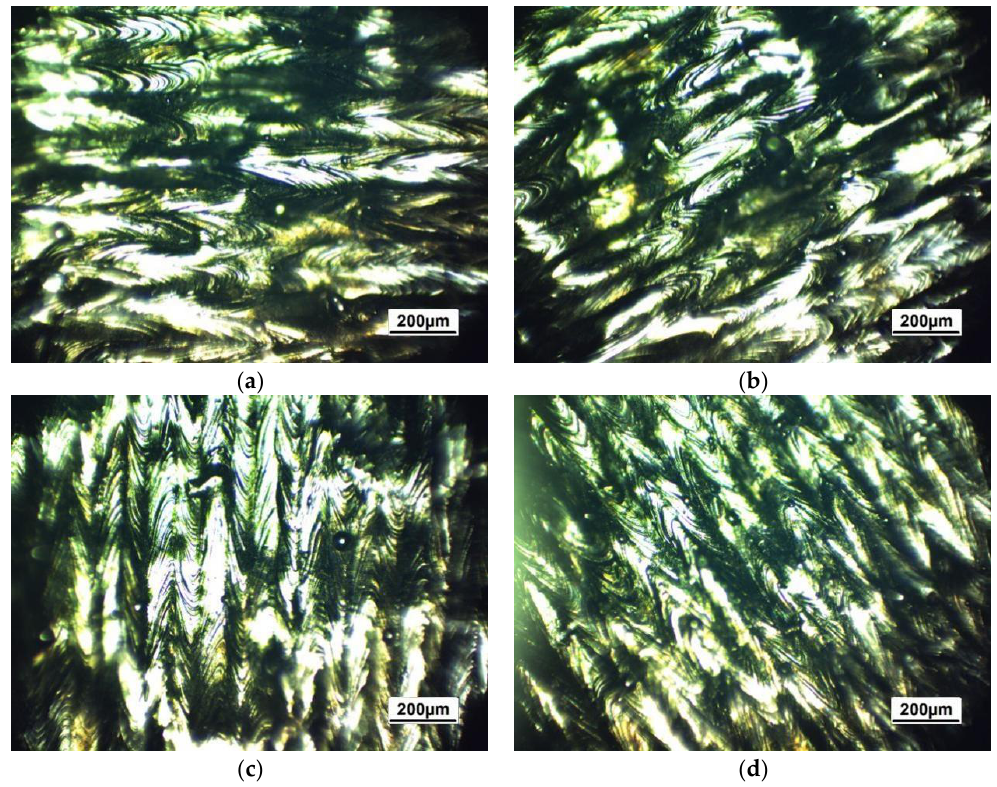
Figure 10. Morphology of the surface molten pool after different angles of SLM formation: ( a ) 0°; ( b ) 30°; ( c ) 90°; and ( d ) 120°.